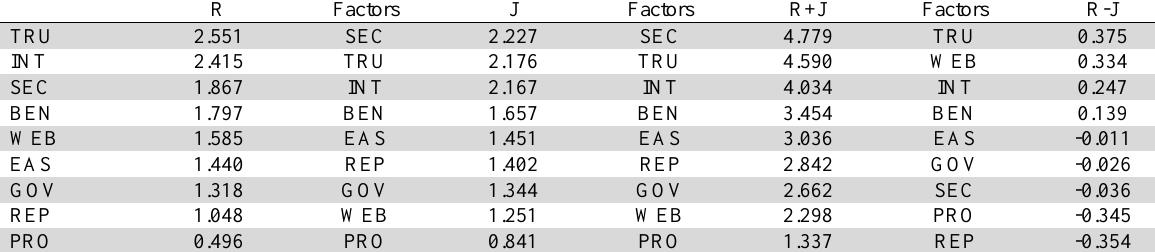
The results of effects of direct/indirect factors